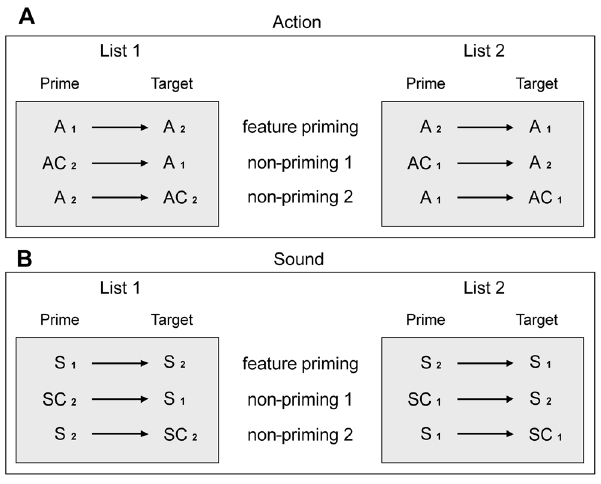
Figure 1. Stimulus lists with different prime target pairings for each condition. The two lists were counterbalanced across partici- pants so that overall the same critical words of each feature type appeared in the feature- and in the non-priming conditions as targets. A 1 /A 2 : first/second set of critical action words, AC 1 /AC 2 : first/second set of action control words, S 1 /S 2 : first/second set of critical sound words, SC 1 /SC 2 first/second set of sound control words.